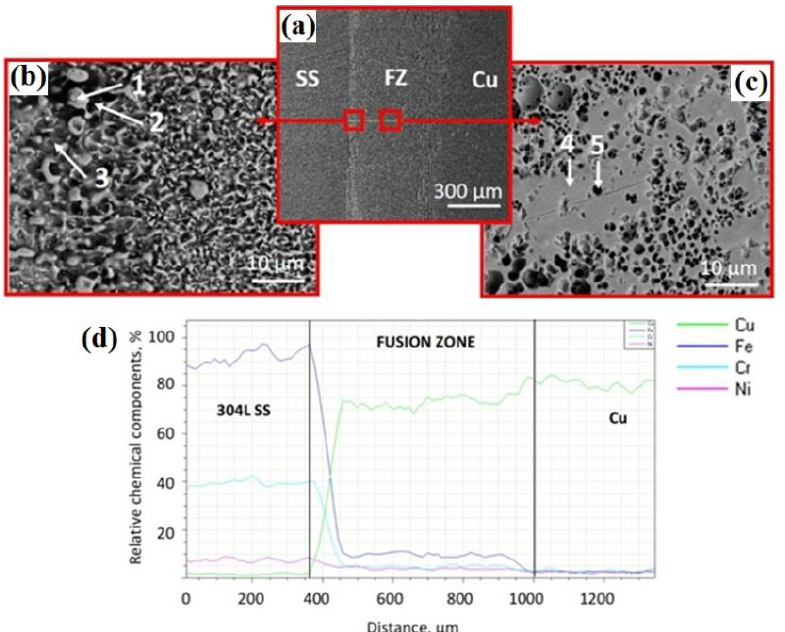
Figure 3. Cross-sectional SEM images of the sample welded with a beam power of 2400 W (Sample 1): ( a ) SEM image of the obtained joint, ( b ) higher-magnification SEM image of the stainless steel (SS) – fusion zone (FZ) interface, ( c ) higher-magnification SEM image of the fusion zone (FZ), and (d) distribution of the elements across the welded joint studied by EDX. Table 1. Chemical composition of each point marked on SEM images of Sample 1. Element, wt.